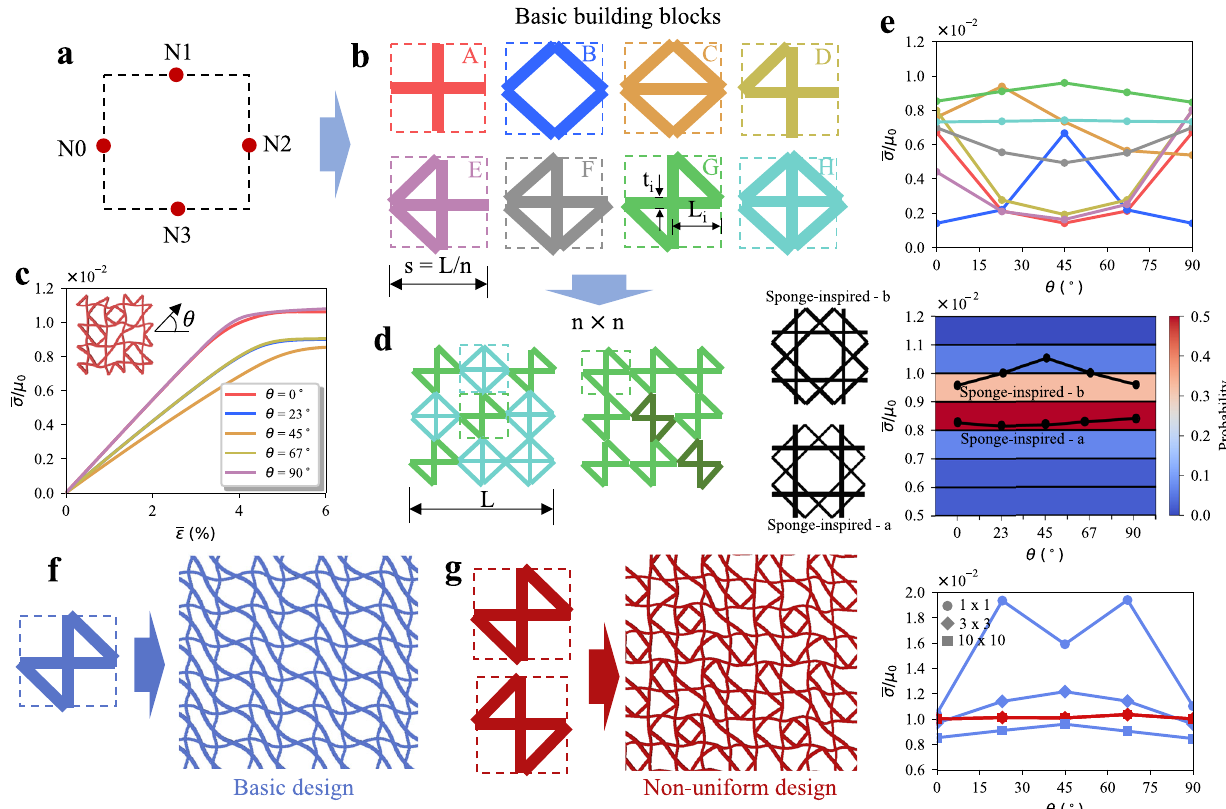
Fig. 1 Non-uniformly assembled lattices. a Initial squared framework with one node per edge (i.e., boundary nodes), identi fi ed by N0, N1, N2, N3 for building block generation. b Unique beam-based building blocks generated by combinatorially connecting the boundary nodes. c Typical stress – strain curves of non-uniform unit cells under uniaxial compression at fi ve different loading directions ( θ ∈ [0°, 23°, 45°, 67°, 90°]). Note that PBCs are imposed with a maximum applied effective strain of 6%. d Examples of n × n non-uniform unit cells with n = 3 composed of two different combinations of building blocks i.e., design G and H, and design G and its 90°-rotated version (identi fi ed by a darker green). e Upper panel: normalized effective buckling strength of the basic building blocks (in b ) as a function of the loading angle θ . The superior quasi-isotropic buckling performance of design G are clear. Central panel: probability that a 4 × 4 non-uniform unit cell exhibits a normalized effective buckling strength within discretized levels (amplitude 0.1 × 10 − 2 ). The data with Ω ⩾ 2% are fi ltered out. Buckling values for sponge-inspired design are added as well as corresponding unit cells. Lower panel: effect of global buckling of uniform (in f ) vs. non- uniform (in g ) design on the buckling strength (colors refer to f and g ). Lines are plotted only to facilitate the interpretation. f Post-buckled shape of a basic uniform design obtained tessellating a single building block (G in this case). Long-wave buckling instability is clearly exhibited. g Post-buckled shape of a non-uniform design obtained by combining two building blocks (G and its 90°-rotated version). Sponge- inspired designs ( a : constant mass ratio of 0.5 between diagonal and non-diagonal beams; b : constant slenderness ratio). All values are obtained by FE simulations (see “ Methods ” section for